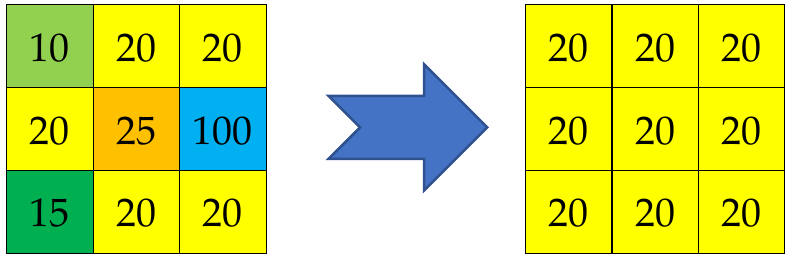
Figure 1 . Median filter model (3*3 matrix) Figure 1. Median filtering model (3 × 3